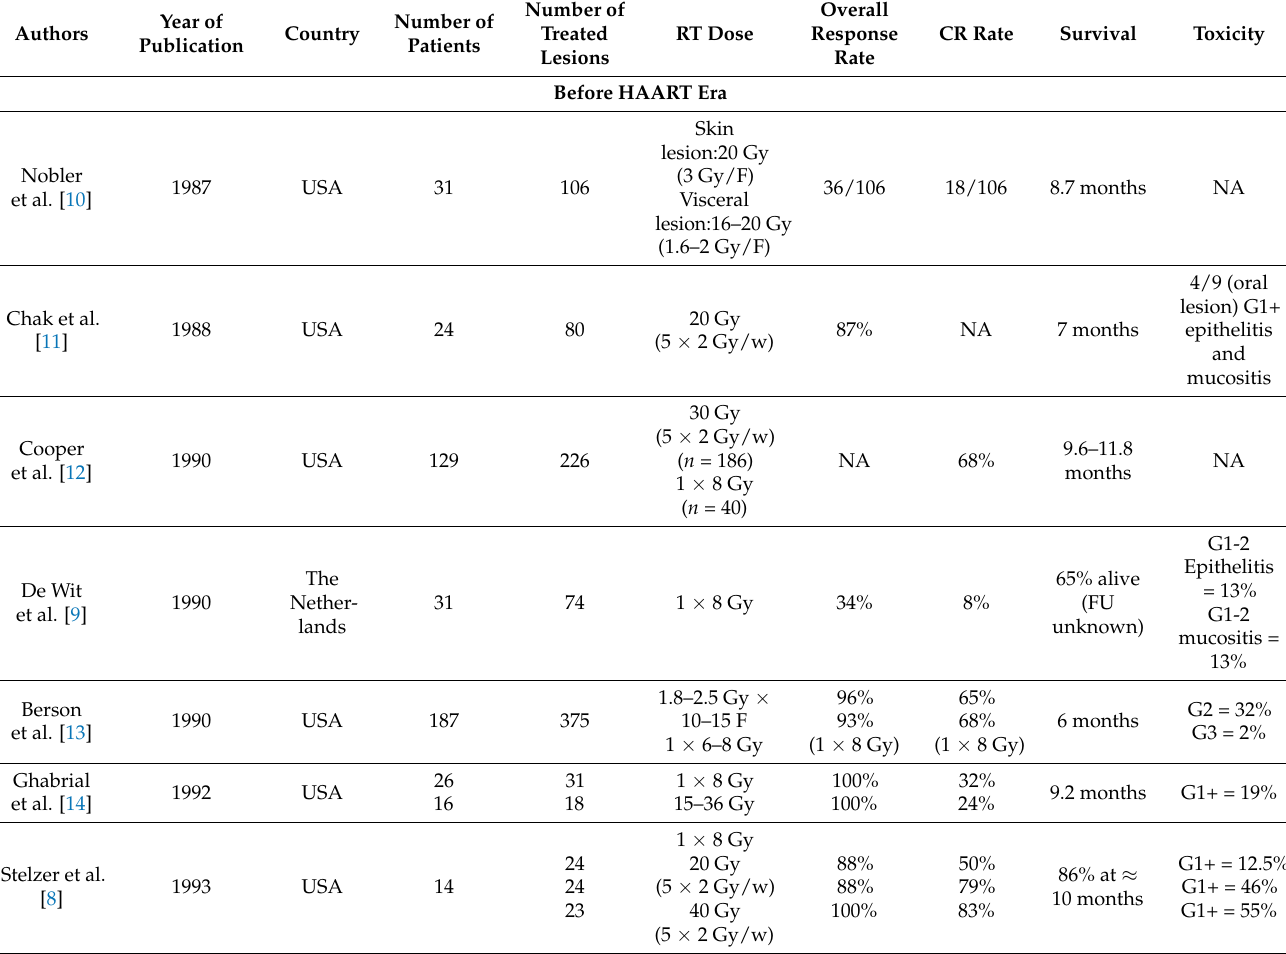
Table 1. Studies of radiotherapy for Kaposi’s Sarcoma in HIV-infected